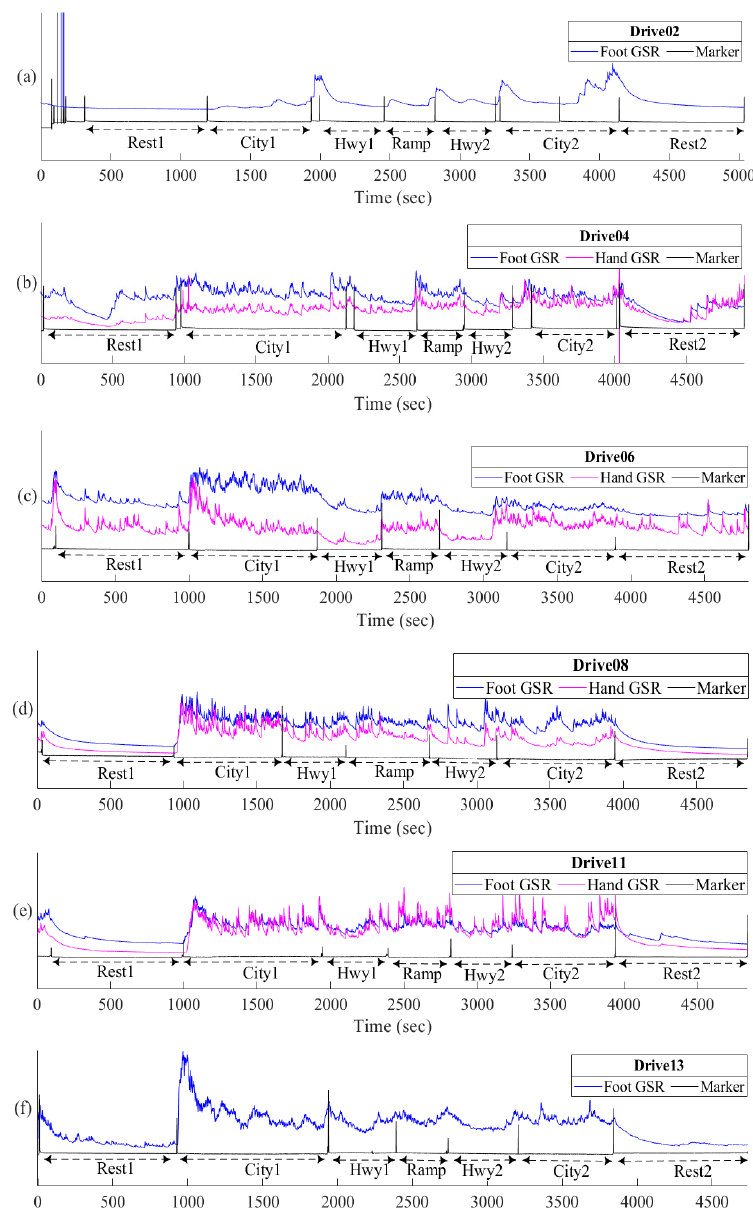
Figure 5. GSR signals and marker signals of the six driving sections of Drive07\10\12\15: ( a ) GSR and marker signals of Drive07; ( b ) GSR and marker signals of Drive10; ( c ) GSR and marker signals of Drive12; ( d ) GSR and marker signals of Drive15. The foot GSR signal of Drive12 was inconsistent with the hand GSR signal, and the study referred to the hand GSR signal.